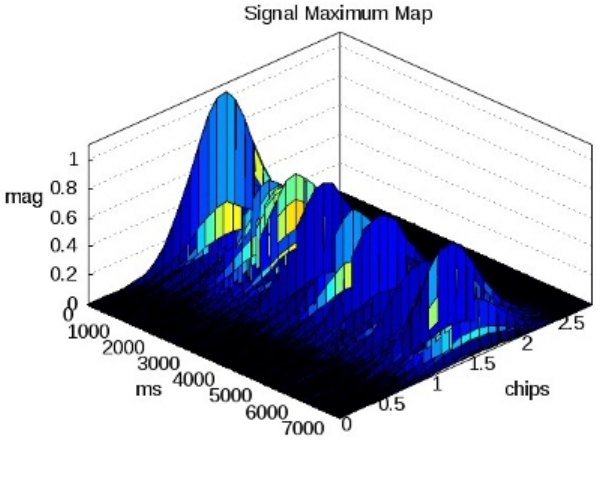
Figure 9. Delay waveform over 7 seconds for the February 4th 2005 reflection